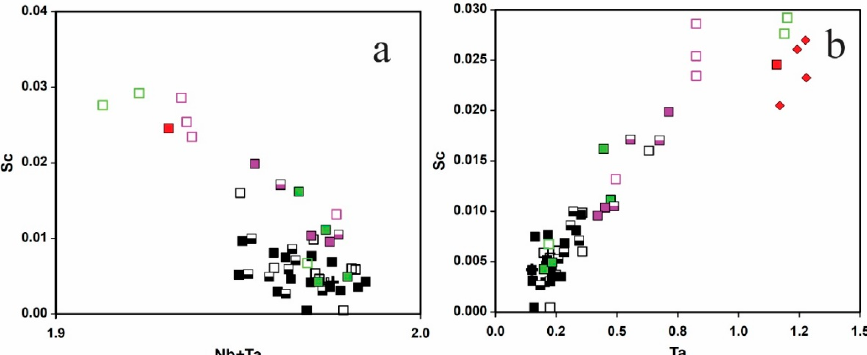
Figure 7. Binary plots for Nb-Ta oxides based on EPMA data. ( a , b ) Sc (in a.p.f.u.) versus Nb + Ta (in a.p.f.u.), and versus Ta (in a.p.f.u.) binary plots. Symbols are the same as in Figure 6.